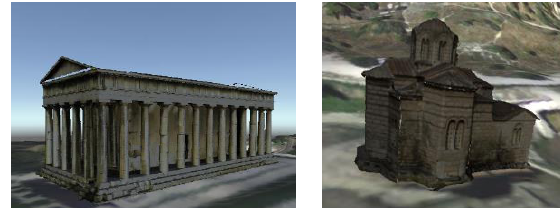
Figure 12: Temple of Hephaestus (left) and Holy Apostles church (right) with the wrong texture